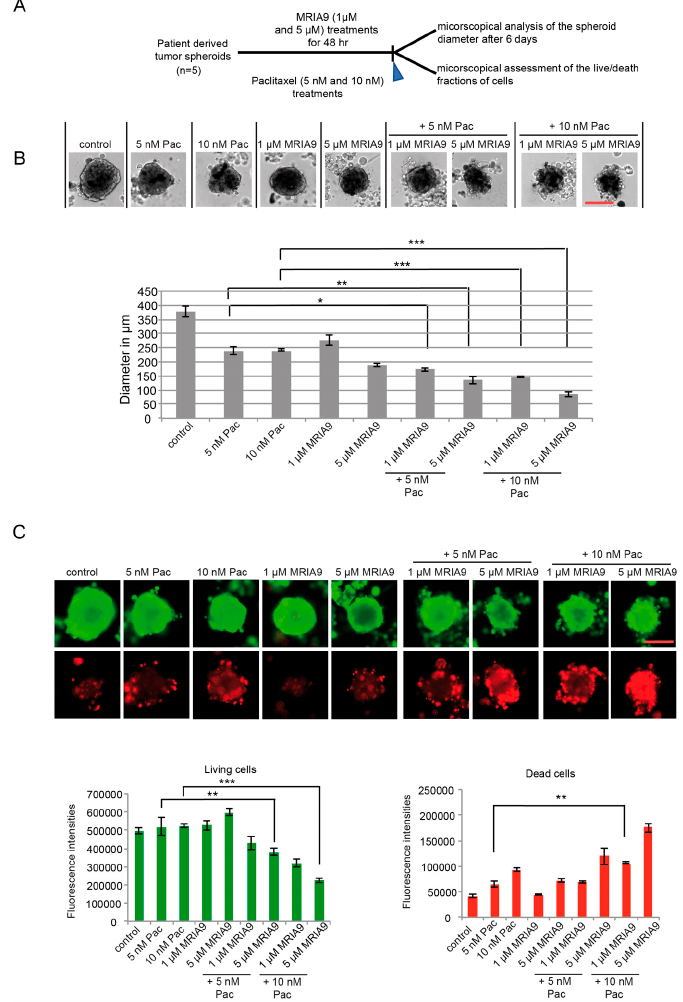
Figure 7. The combination Pac/MRIA9 blocks the growth and strongly enhances apoptosis-dependent death of patient derived ovarian tumor cells. ( A ) Scheme of the experimental procedure. 3D spheroids grown from tumor cells of primary patients were treated with 1 µM and 5 µM MRIA9 for 48 h. 5 nM and 10 nM paclitaxel were subsequently added to the spheroid cultures for 6 days. At the end of the incubation time, the spheroid diameters were assessed microscopically, and the live/dead fractions were quantified using immunofluorescence. ( B ) (Upper) Representative images of the patient derived spheroids that underwent single Pac and MRIA9 treatments or the combination Pac/MRIA9 after six days. Scale bar = 150 µm. (Lower) Growth inhibition after six days represented by the spheroid diameters is displayed as mean ± SD (*** p < 0.001, ** p < 0.01, * p < 0.05 ( n = 5). ( C ) Patient derived spheroids were stained for immunofluorescence, and the live/ dead fractions were quantified. (Upper) Representative images of the patient derived spheroids that underwent the different treatments Scale bar = 150 µm. (Lower left) The fluorescence intensities of the living fraction in the different treatment groups were quantified and represented as mean ± SD. *** p < 0.001, ** p < 0.01. (Lower right) The fluorescence intensities of the dead fraction in the different treatment groups were quantified and represented as mean ± SD. ** p < 0.01.